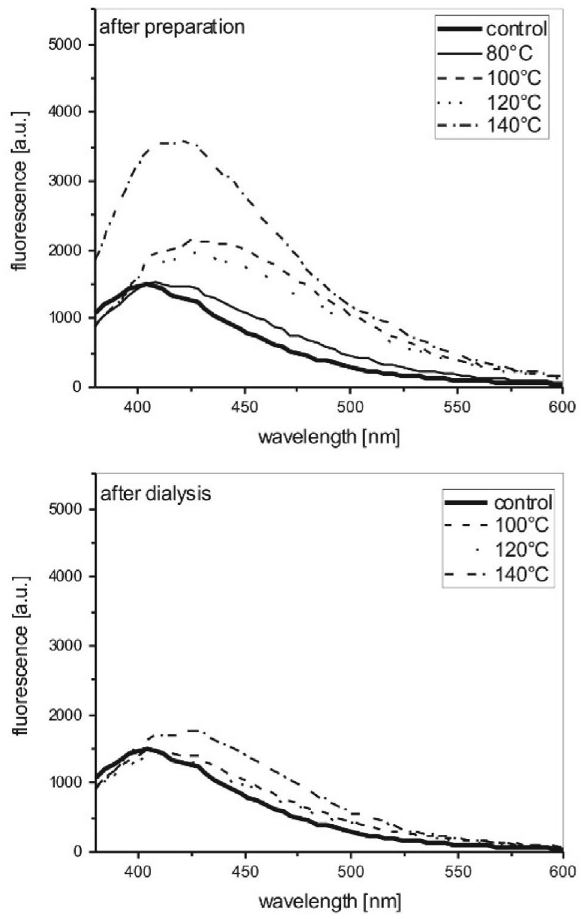
Figure 6. Fluorescence emission spectra of the prepared solutions. For activation, light with 360 nm is used. Presented are spectra from solutions prepared at different process temperatures with a process duration of 5 minutes.